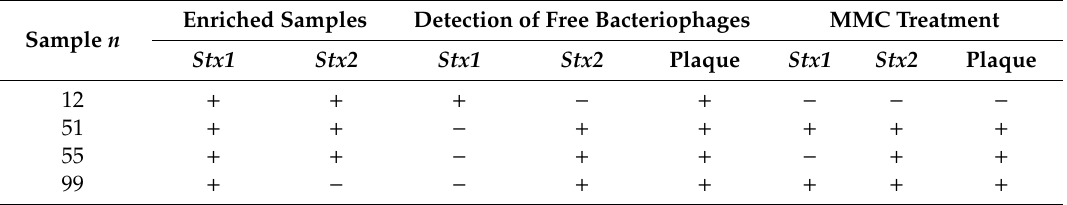
Table 3. E ff ect of the stx bacteriophages to qPCR-positive / culture-negative